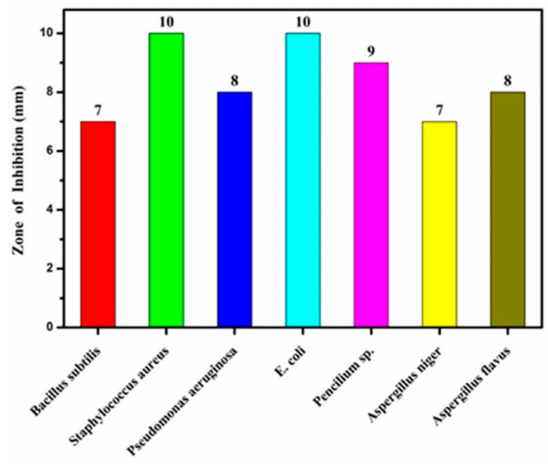
Figure 12. Zones of inhibited FNH for bacteria and fungi. Table 4. Biological activity of α -Fe2O3 nanoparticles. Zone of Inhibition